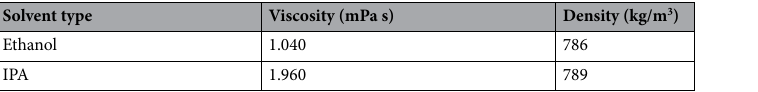
Table 1. Viscosity and density at 25 °C of each solvent. Each property was obtained by built-in database in COMSOL Multiphysics 5.5.